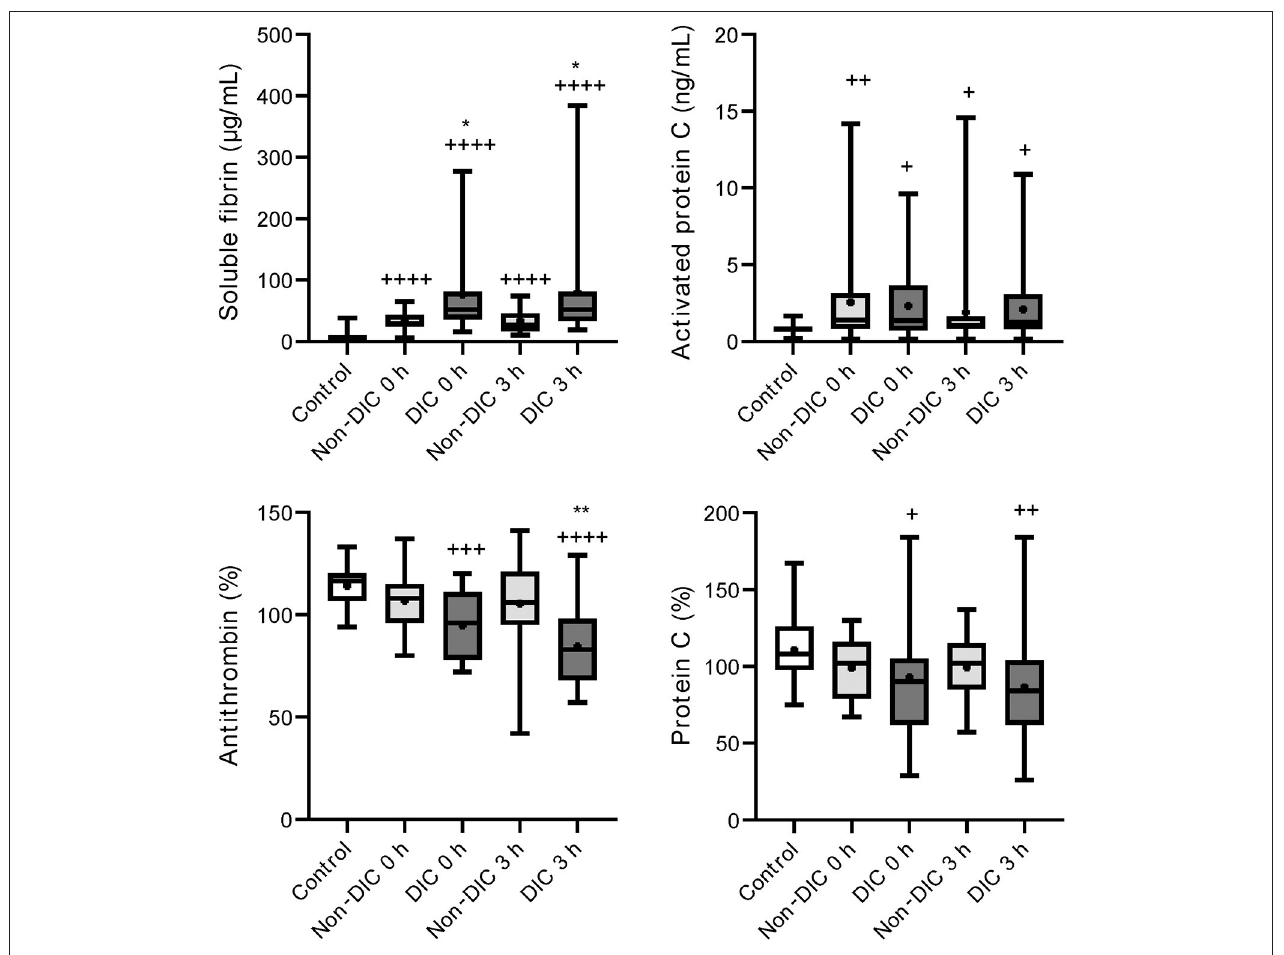
FIGURE 5 | Serial changes in the coagulation-related molecular markers in patients with isolated traumatic brain injury. Healthy controls (white box), non-disseminated intravascular coagulation (DIC) (light gray boxes), and DIC (dark gray boxes) at presentation to the emergency department (0h) and 3h after hospital arrival (3h). Horizontal bars in the box indicate the median (middle) and interquartile ranges (upper 25% and lower 75%). Black boxes represent the mean values. + p < 0.05 vs. healthy controls, ++ p < 0.01 vs. healthy controls, + + + p < 0.001 vs. healthy controls, + + ++ p < 0.0001 vs. healthy controls, * p < 0.05 vs. non-DIC, ** p < 0.01 vs.